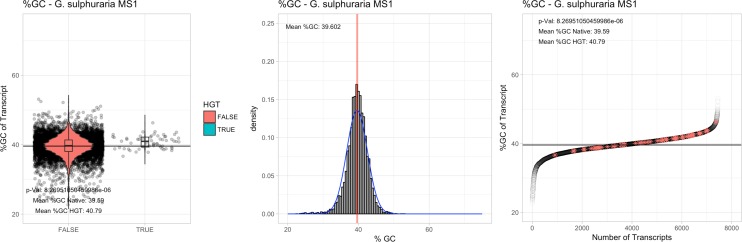
%GC – Galdieria sulphuraria MS1: (Left) Violin plot showing the %GC distribution across native transcripts and HGT candidates.(Mid) Cumulative %GC distribution of transcripts. Red line shows the average, blue line a normal distribution based on the average value. (Right) Ranking all transcripts based upon their %GC content. Red ‘*' demarks HGT candidates. As the %GC content was normally distributed, students test was applied for the determination of significant differences between the native gene and the HGT candidate subset.